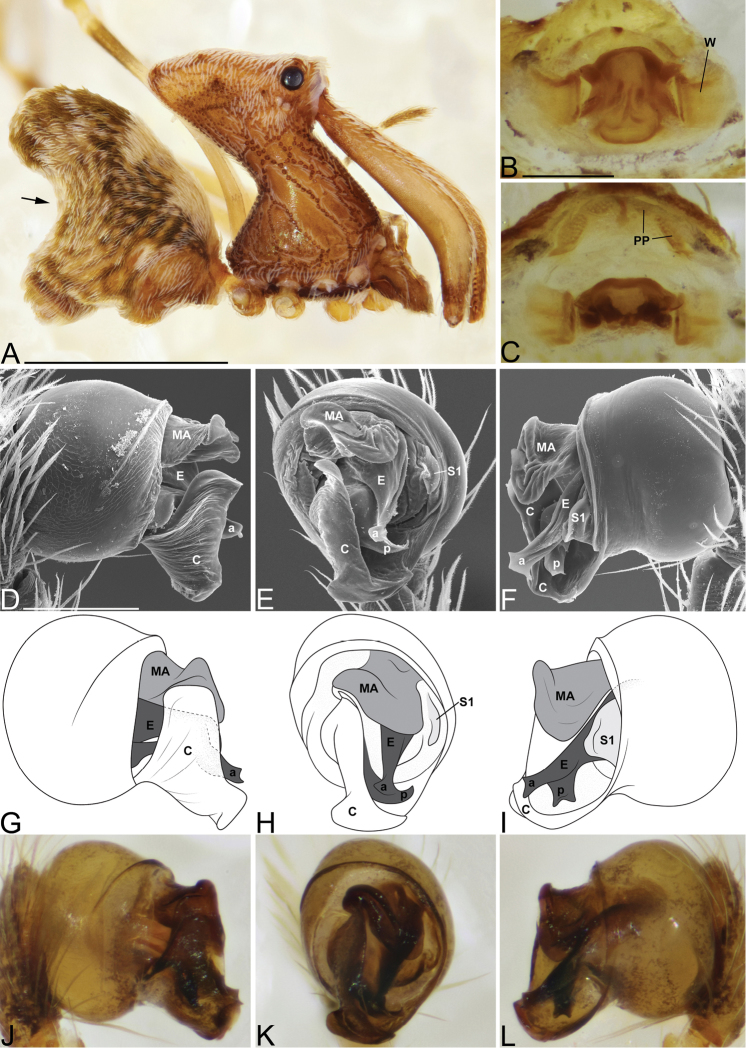

Madagascarchaea
lotzi sp. n. A male (CASENT9018921) habitus, lateral view, arrow showing posterior invagination of abdomen B–C female (CASENT9012008) internal genitalia B dorsal view C anterior view D–L male pedipalpal bulbs D–F right bulb (CASENT9012004), image reversed, G–L left bulb (CASENT9012330) D, G, J prolateral view E, H, K ventral view F, I, L retrolateral view. Scale bars: 1 mm (A); 0.125 mm (B, D).